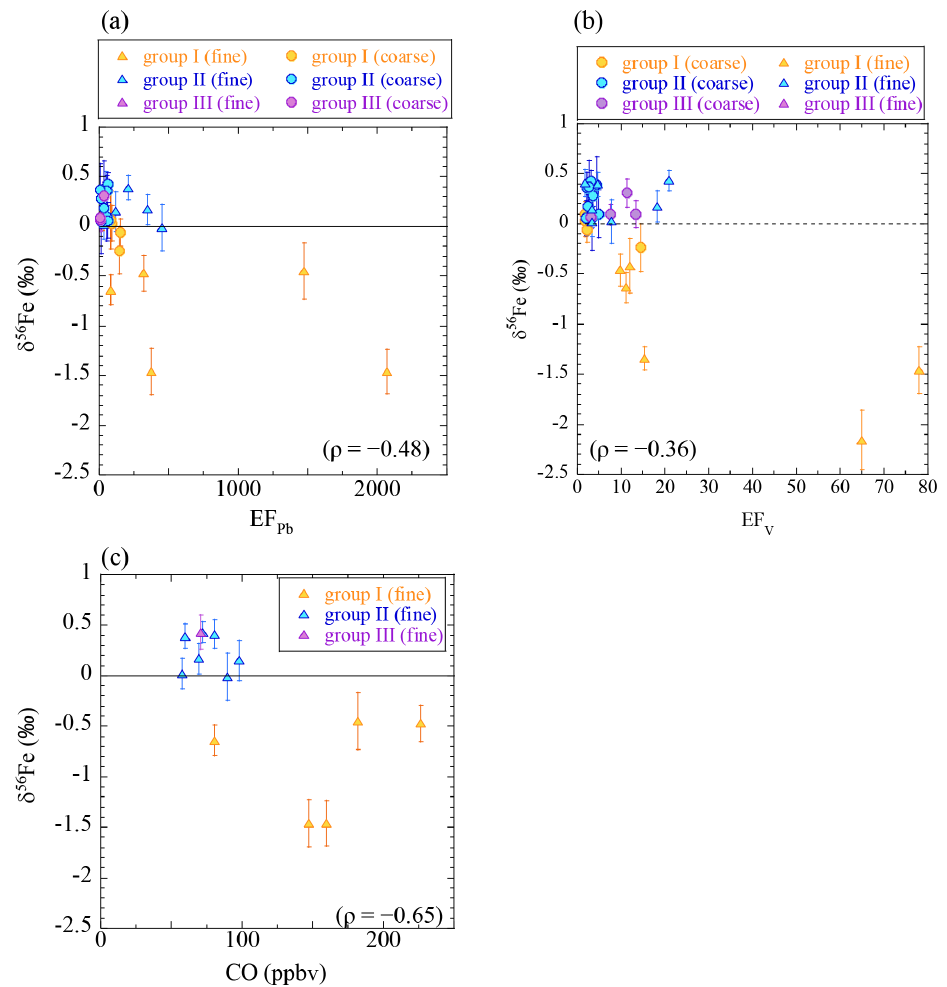
Figure 7. Scatter plots of Fe isotope ratios and (a) EF Pb , (b) EF V , and (c) CO. Concentrations of CO were averaged values during the sampling period (data from Kamezaki et al., 2019). ρ is the Spearman rank order correlation coefficient ( p< 0 . 05). Yellow, group I; blue, group II; purple, group